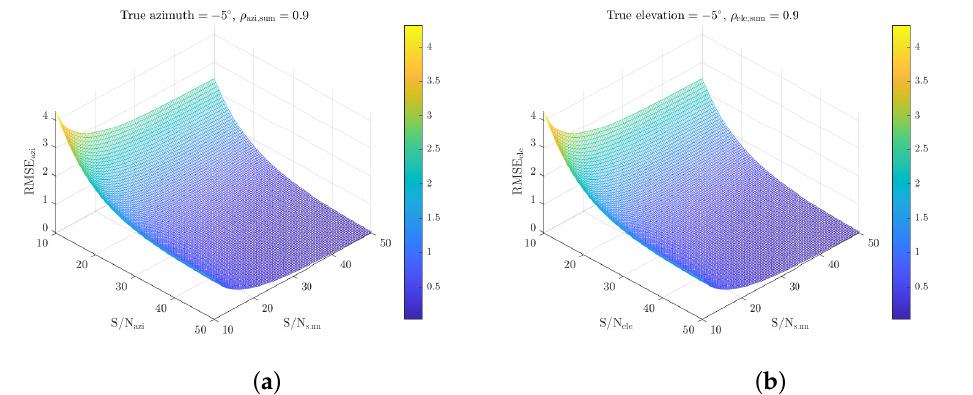
Figure 15. RMSE for difference channel SNR and sum channel SNR ( θ azi , θ ele = − 5 ◦ , ρ azi,sum = 0.9). ( a ) RMSE of ˆ θ azi . ( b ) RMSE of ˆ θ ele